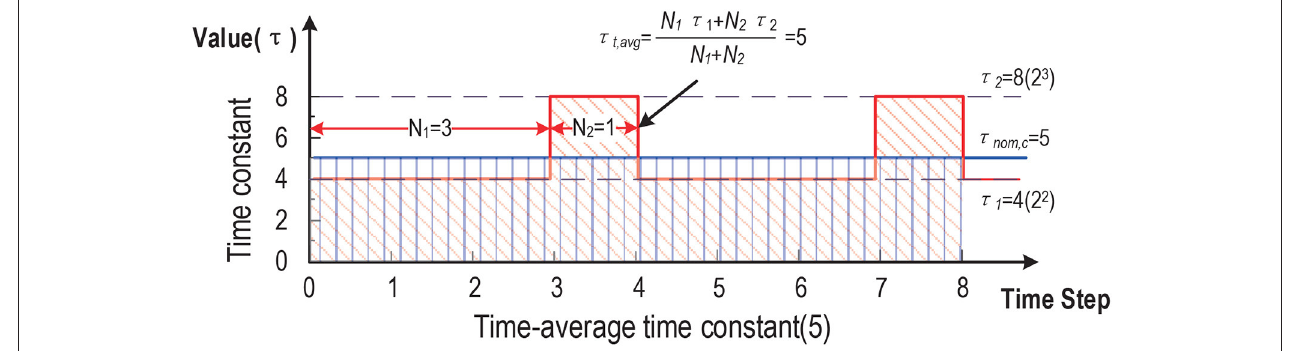
FIGURE 5 | Time-averaged time constants: the realized averaged time constant is 5.